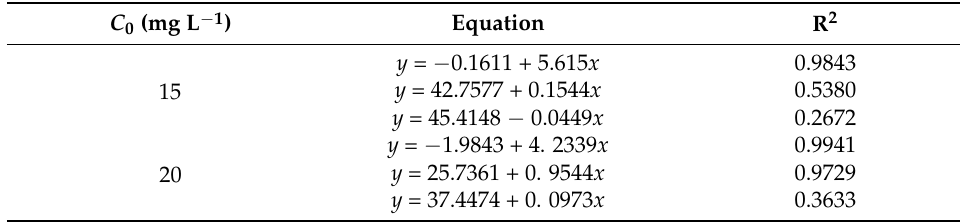
Table 2. Fi tt ed date of intra-particle di ff usion model. Table 2. Fitted date of intra-particle diffusion